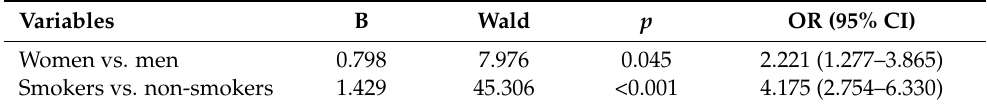
hazardous drinker ardous drinker criteria.